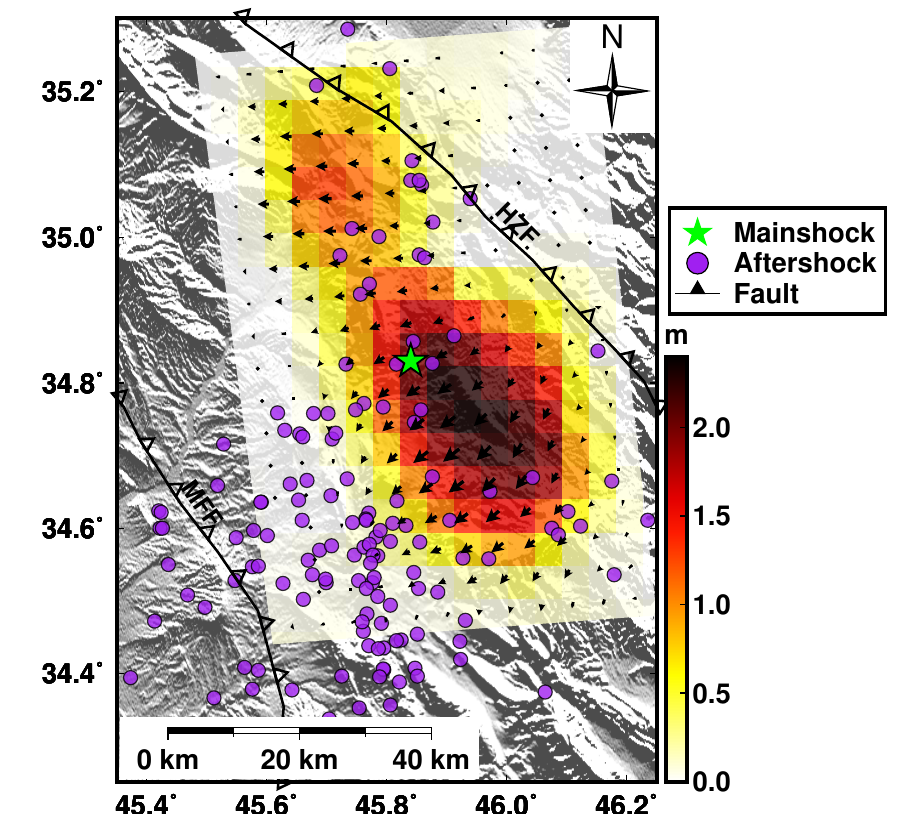
Figure 8. Slip distribution for the modeled seismic source. The cyan star is the epicenter. The purple circles indicate aftershocks (M W > 3.0) during the 220 days after the mainshock (from http://irsc.ut.ac. ir/bulletin.php). Black lines denote faults, HZF: High Zagros fault, MFF: Zagros Mountain Front